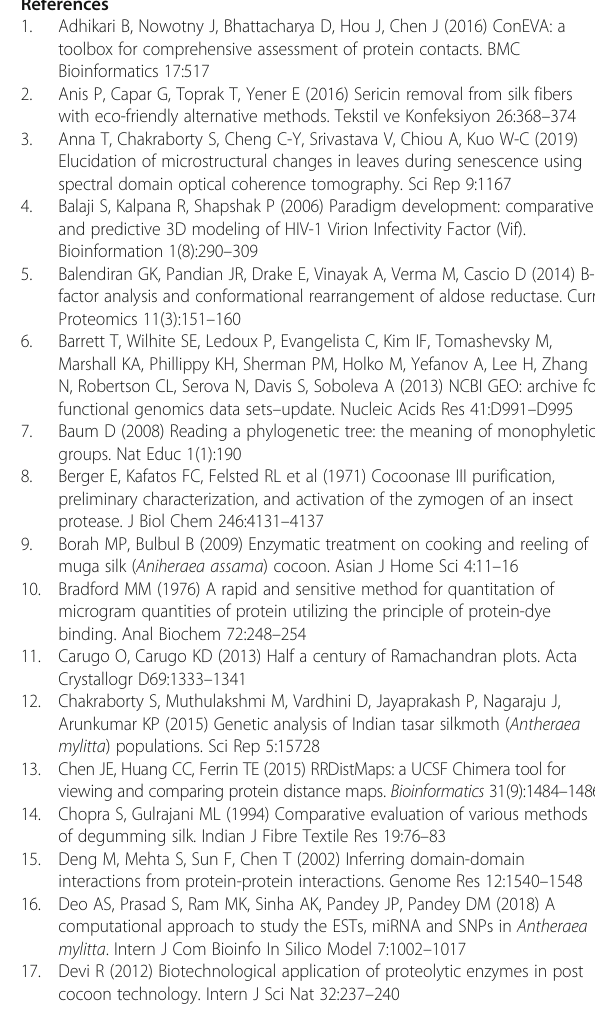
Additional file 1: Supplementary Figure 1. Predicted secondary structure of cocoonase (a) and sericin (b). In cocoonase and sericin lines in different colors represent different secondary structures: Blue for α helix, green for β turn, red for extended strand, and purple for random